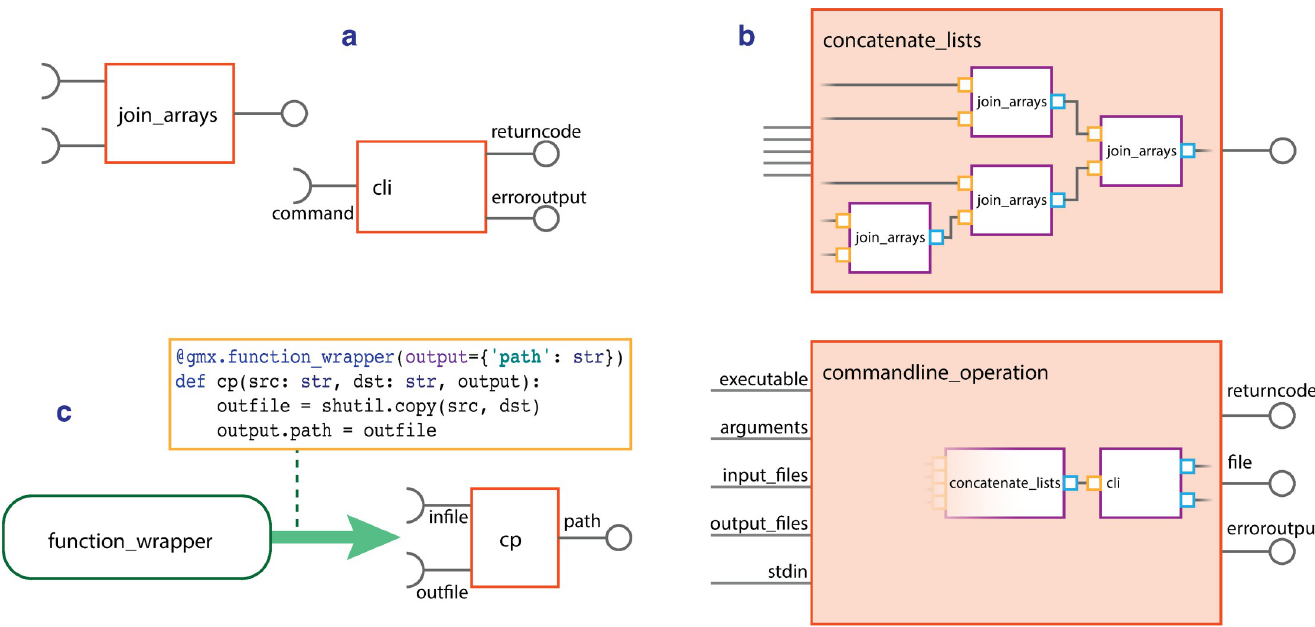
Fig 3. Schematics for gmxapi operations. As shown in panel (A), gmxapi operations have well defined inputs and outputs. These can operate on arrays of inputs and also include support for legacy GROMACS operations by wrapping the command-line toolset, as shown in panel (B). As shown in panel (C), the decorator @function_wrapper allows arbitrary user code to be transformed into a gmxapi